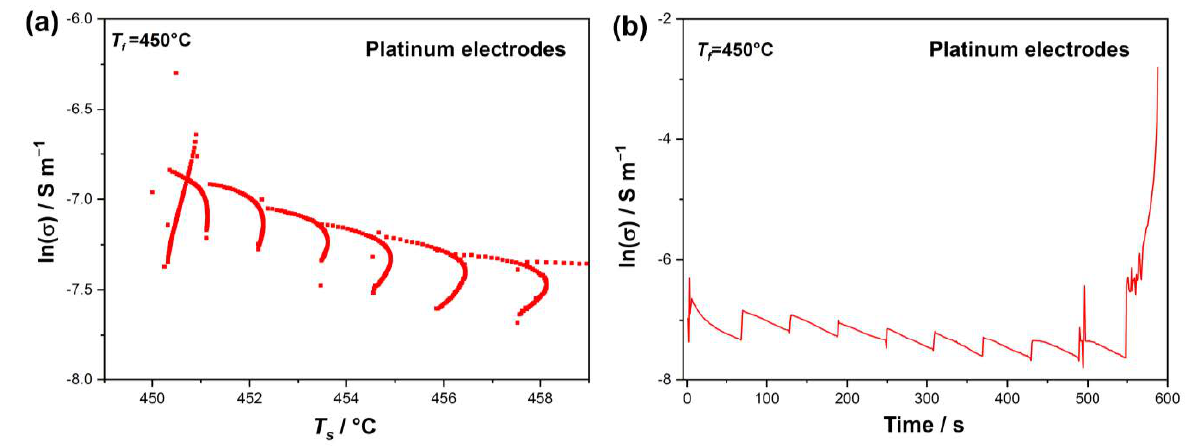
Figure 6. ( a ) Logarithm of conductivity in the temperature range of 450 ◦ C and 462 ◦ C for the Pt sample treated at T f = 450 ◦ C. ( b ) The logarithm of conductivity as a function of time for the Pt sample tested at 450 ◦